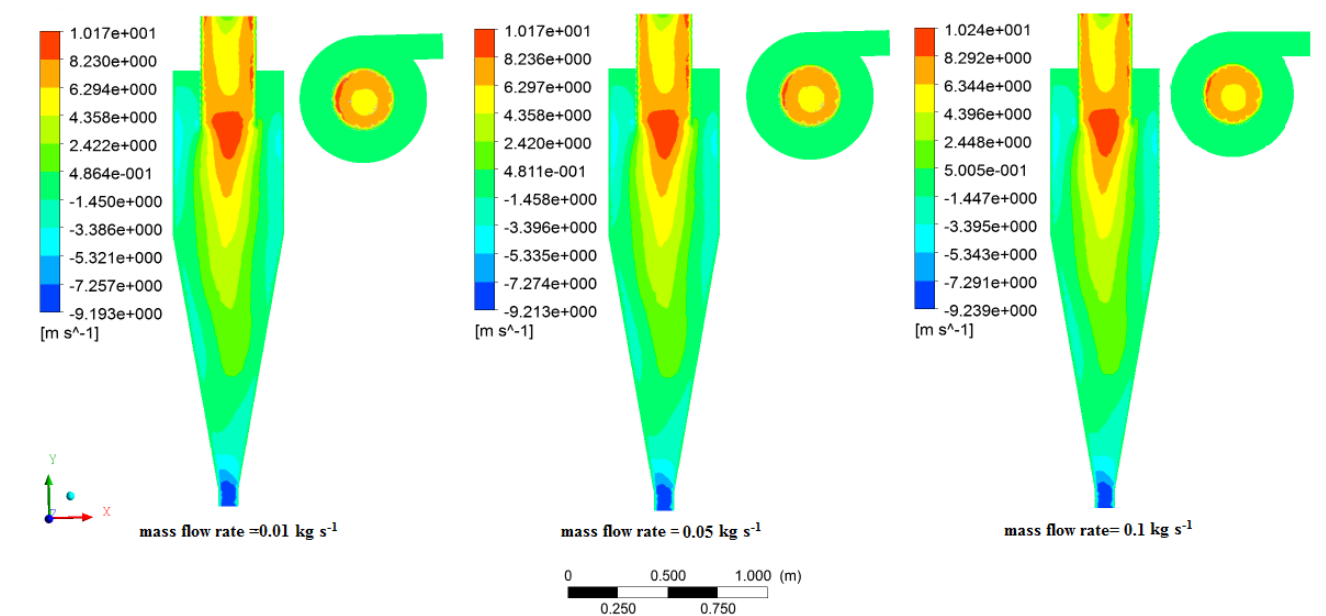
Figure 8. Axial velocity contours in various mass flow rates.